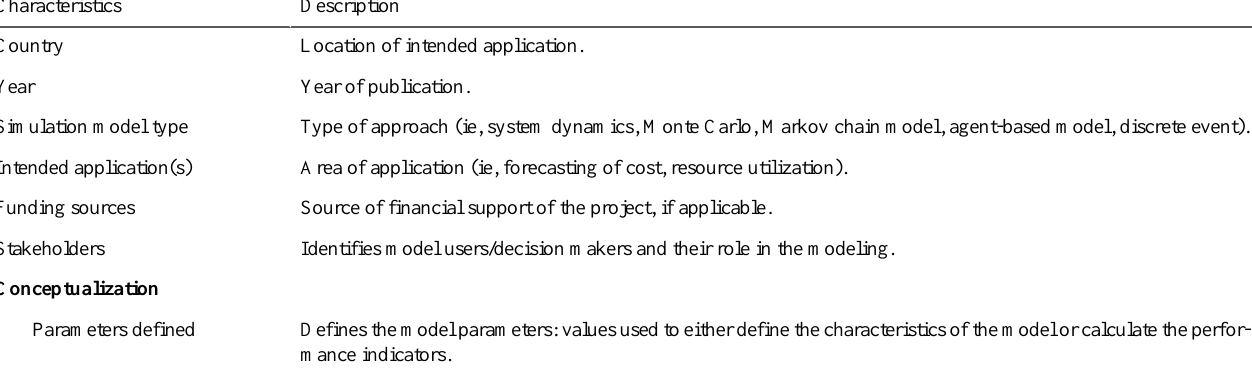
Table 1. Model characteristics and validation.